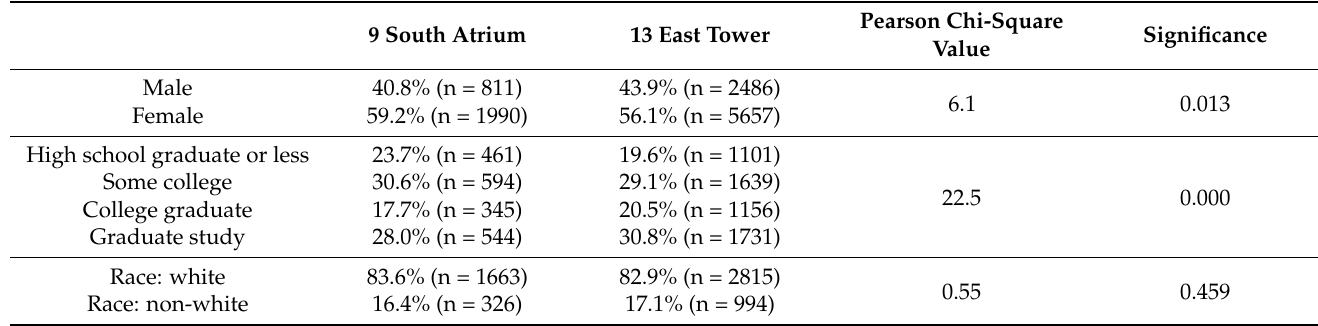
Table 3. Comparison of gender, education, and race between 9 South and 13 East.